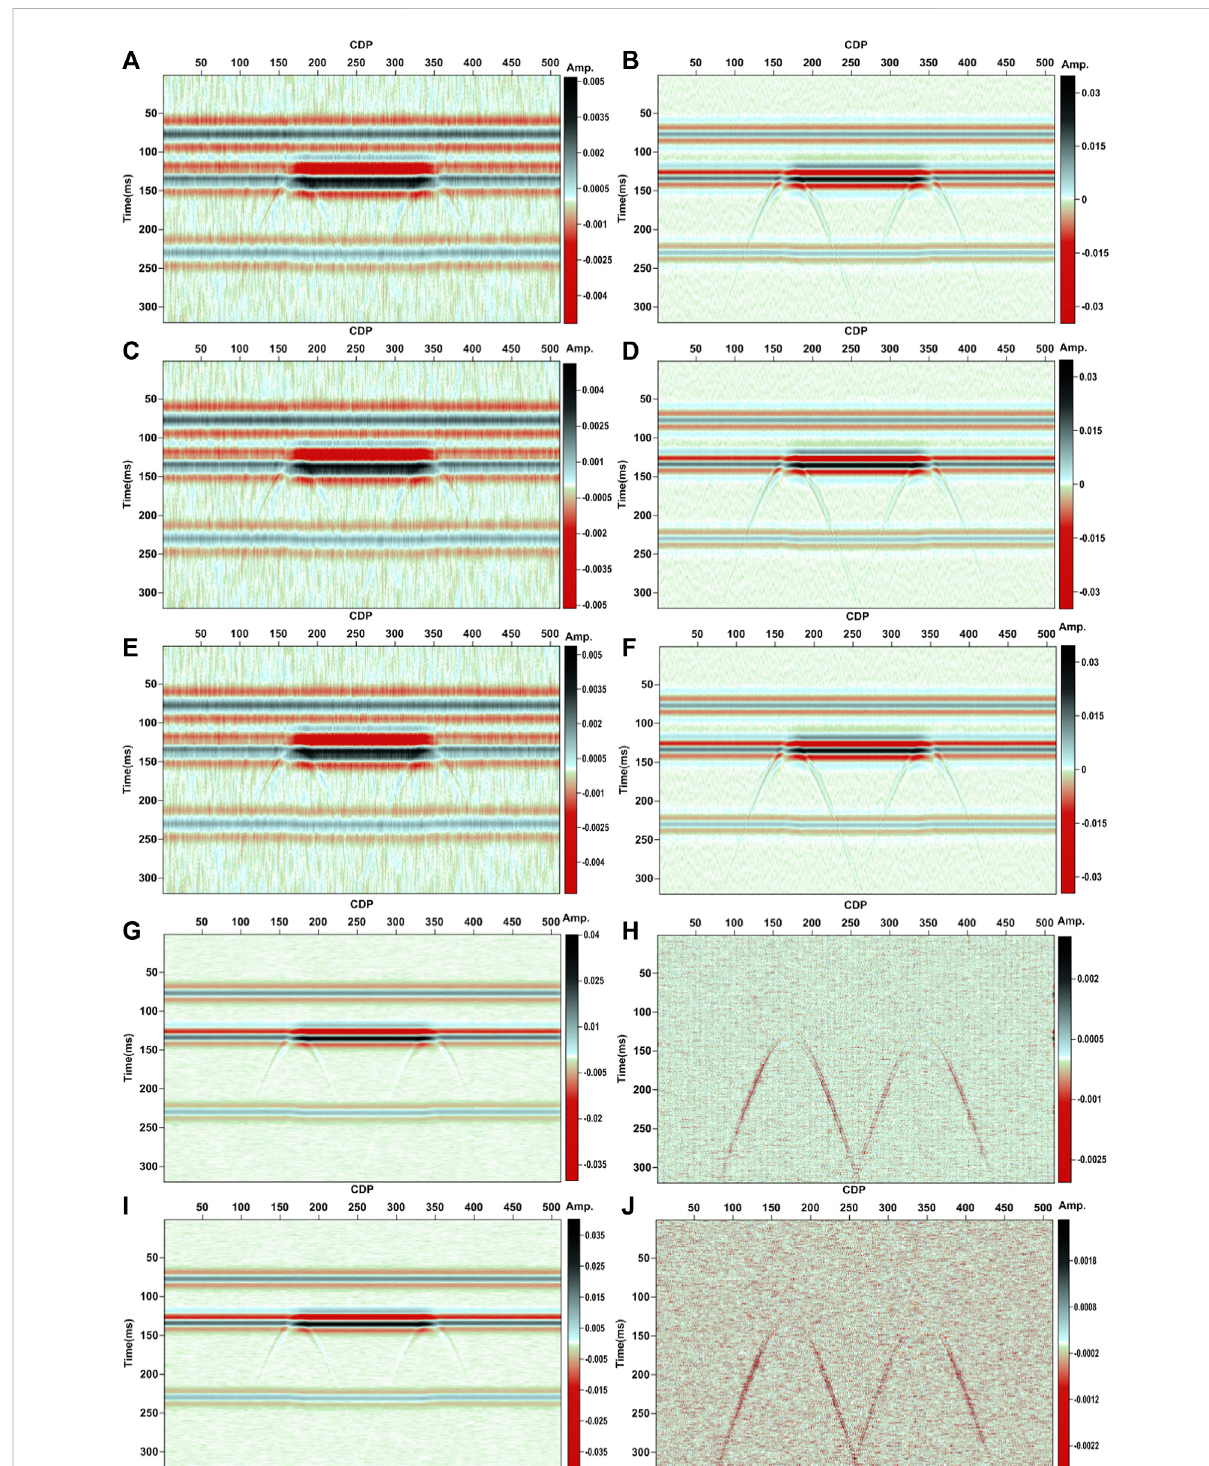
FIGURE 9 IMFscomparisonofthedifferentchannels forthenoisydatainFigure1B. (A) IMF1withchannel3. (B) IMF2withchannel3. (C) IMF1withchannel 9. (D) IMF2with channel 9. (E) IMF1 with channel 200. (F) IMF2 with channel 200. (G) IMF1 with channel 400. (H) IMF2 with channel 400. (I) IMF1with channel 512. (J) IMF2 with channel